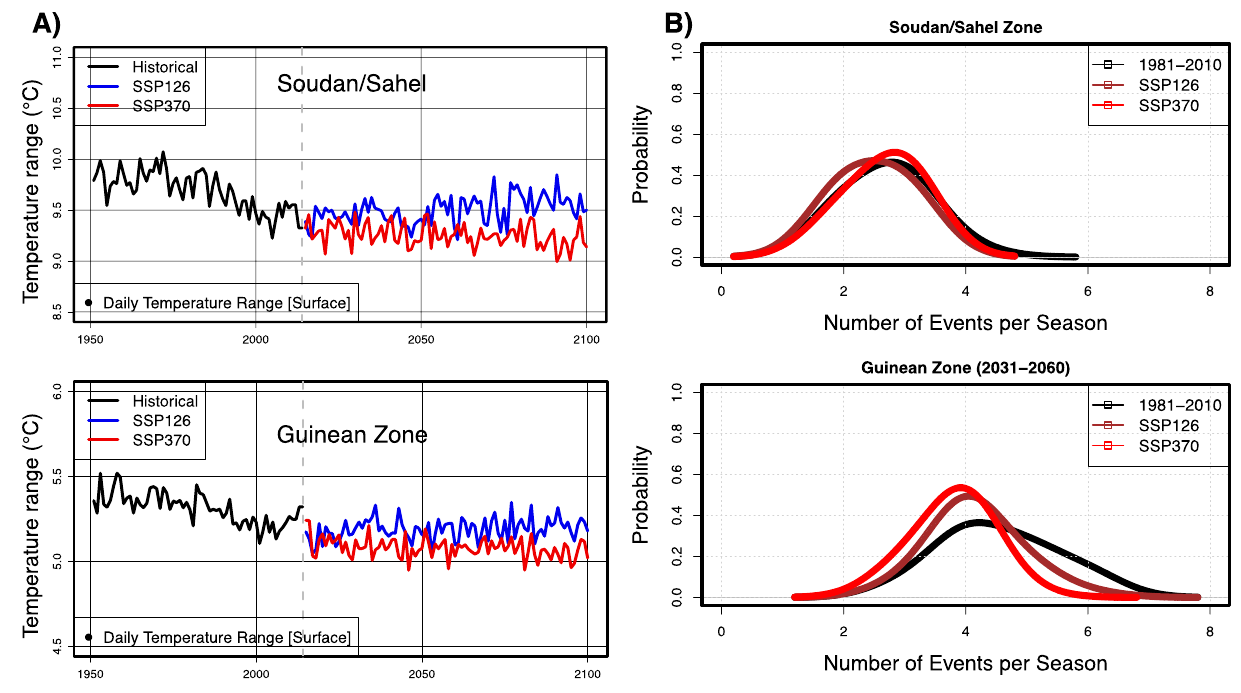
Figure 1. ( A ) Interannual variability and trends of the daily average temperature range (DTR) based on the near-surface temperature depicted in the Soudan/Sahel and Guinean zones of West Africa. The 1950–2014 series is based on observations combining in situ and gridded data. Projections over 2015–2100 are derived from the shared socioeconomic pathways SSP126 & SSP370 scenario using five bias-corrected and downscaled global circulation models from the intersectoral impact intercomparison project (ISIMIP3b). ( B ) Average seasonal distribution of heavy rain events (HRE) during the 2031–2060 horizon over the climatic zones of West